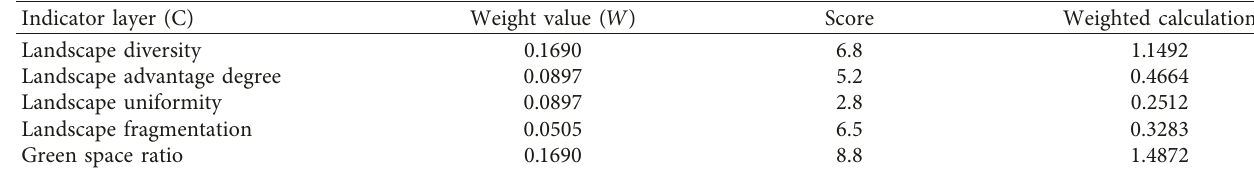
Table 13: X410 ecological landscape index weighted calculation result.